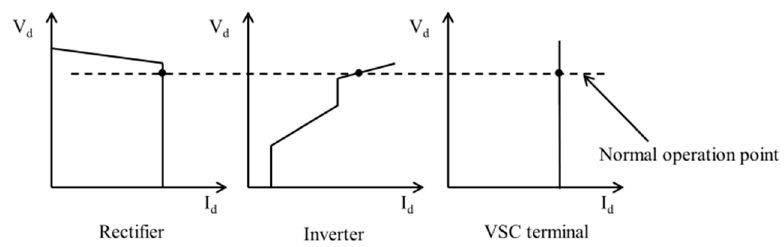
Figure 11. Hybrid MTDC operation characteristics.